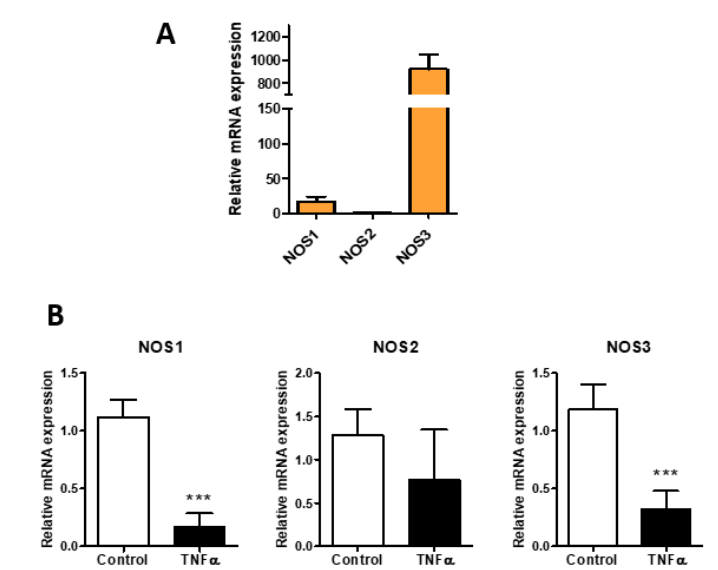
Figure 1. Effect of TNF- α on NO synthetic enzymes in HUVEC. ( A ) relative expression of NOSs (neuronal NOS1, inducible NOS2, and endothelial NOS3) in HUVEC. ( B ) NOSs expression in HUVEC untreated (control) and treated with TNF- α (0.1 µg/mL) for 24 h. Data are mean ± S.E.M. of three independent experiment, *** p < 0.001.